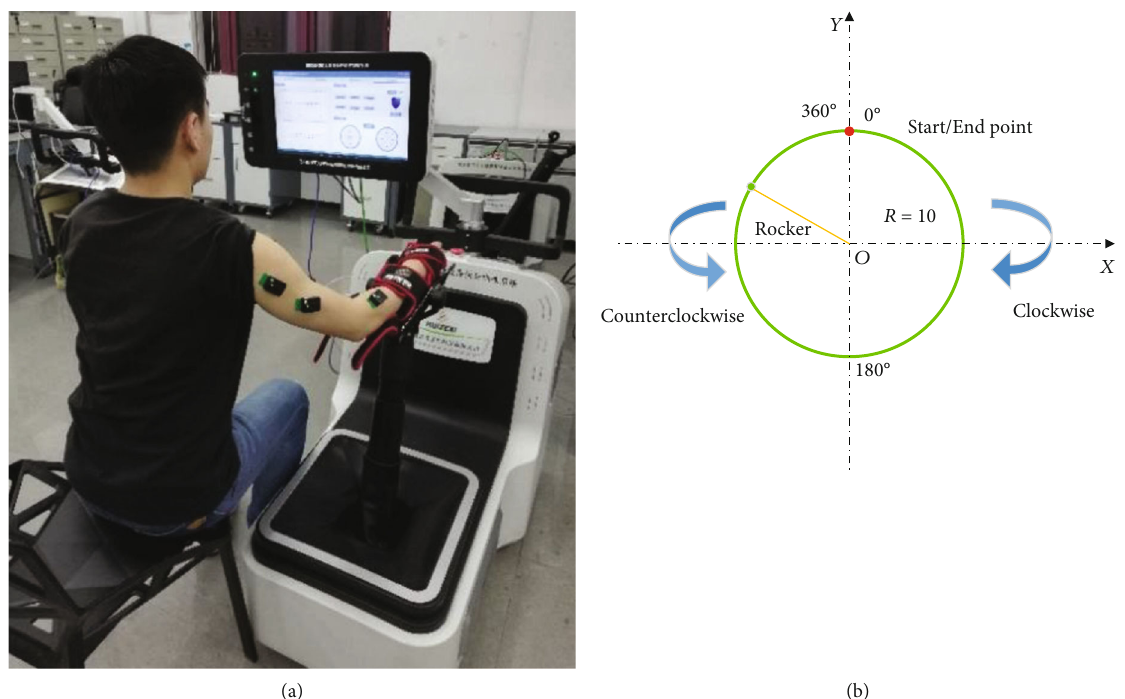
Figure 1: Setup and experimental design. Participants were asked to keep their upper body stable, and their forearm was tied to the joystick of EULRR. (a) Participants sit on the left side of EULRR to implement circle-drawing movement by using their right hands; (b) the illustration of clockwise and counterclockwise circle-drawing movements with constraint of EULRR